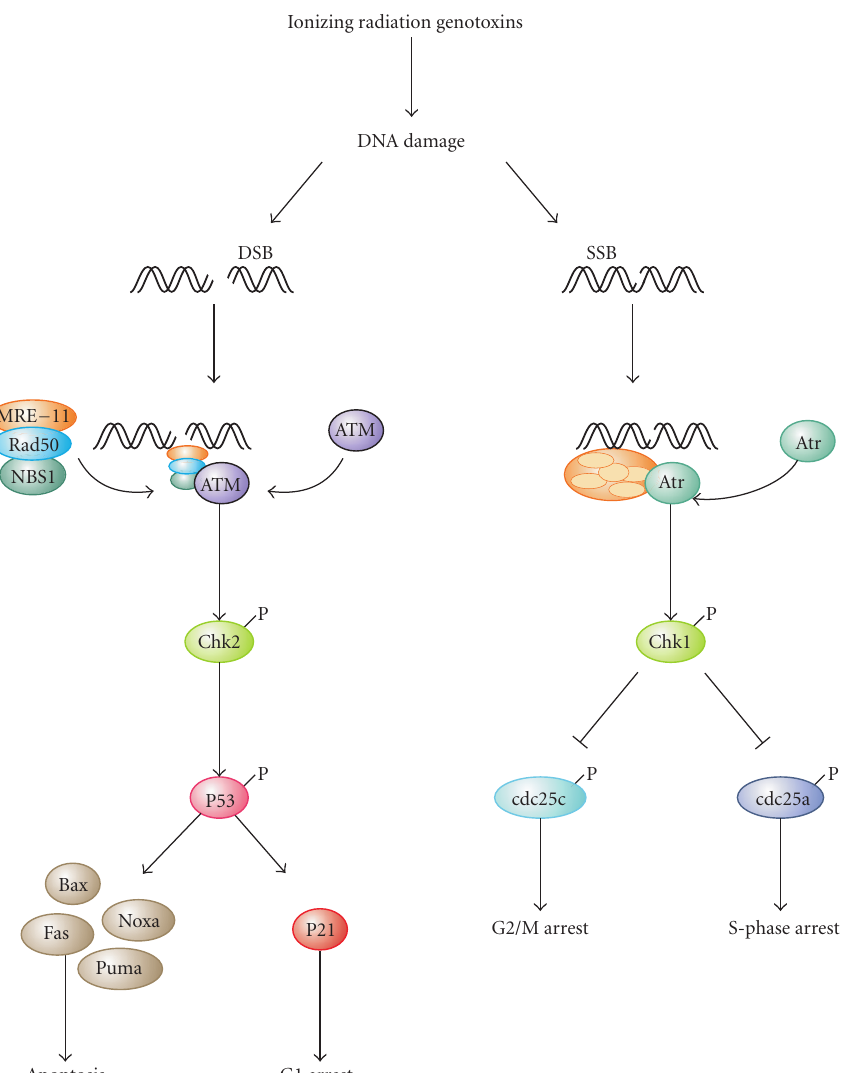
Figure 3: DNA damage responses and cell death. Upon exposure to ionizing radiation or genotoxins, the damage to DNA is a common initial event. DNA double strand breaks (DSBs) or single strand breaks (SSBs) are considered to be key lesions that initiate activation of the DNA damage response. Upon DSBs, ataxia telangiectasia mutated (ATM) is recruited by the MRE-11-Rad50-NBS1 (MRN) complex to sites of broken DNA and phosphorylates downstream substrates such as checkpoint kinase 2 (Chk2), which subsequently phosphorylates p53. Sublethal damage to DNA can engage survival pathways via p21-mediated cell cycle arrest. Alternatively—if the damage is too severe to be repaired—pro-apoptotic p53 target genes are activated including Bax, Puma, Noxa, and Fas, which promote apoptosis. Upon SSBs, it is ataxia telangiectasia and Rad3 related (ATR) that gets activated and phosphorylates Chk1. Chk1 in turn phosphorylates and inhibits cdc25c to mediated G2/M arrest or alternatively cdc25a to promote S-phase